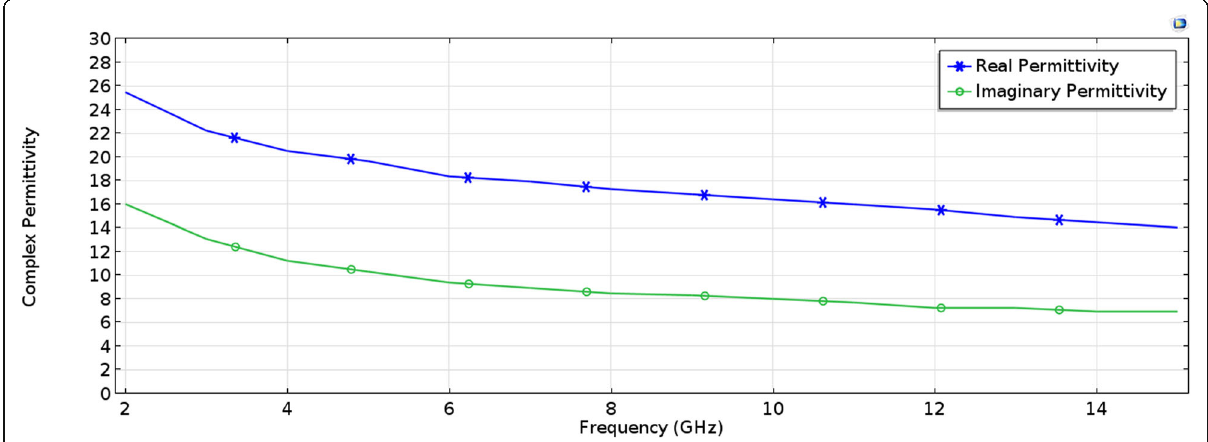
Fig. 2 Complex permittivity of graphite SLS